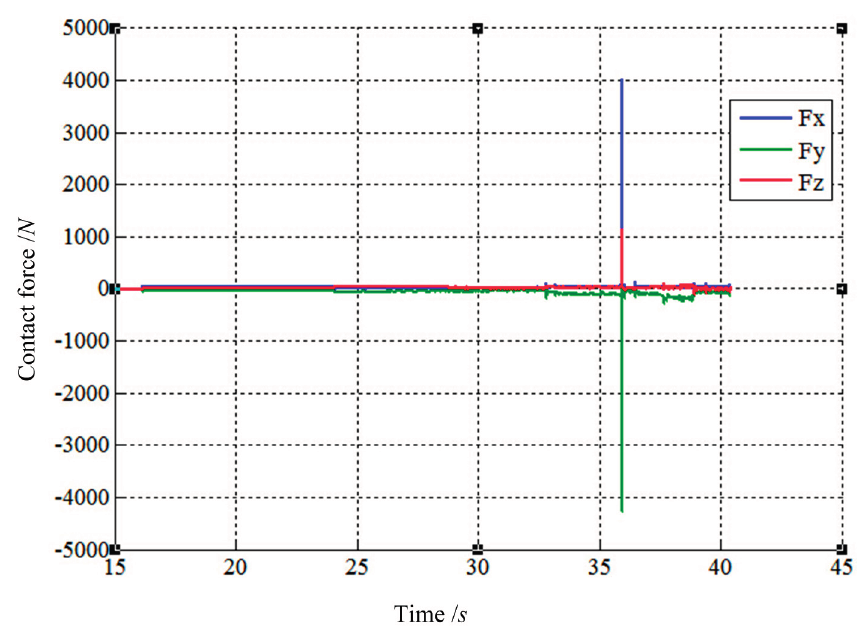
Figure 20. The force tracking results based on Equation